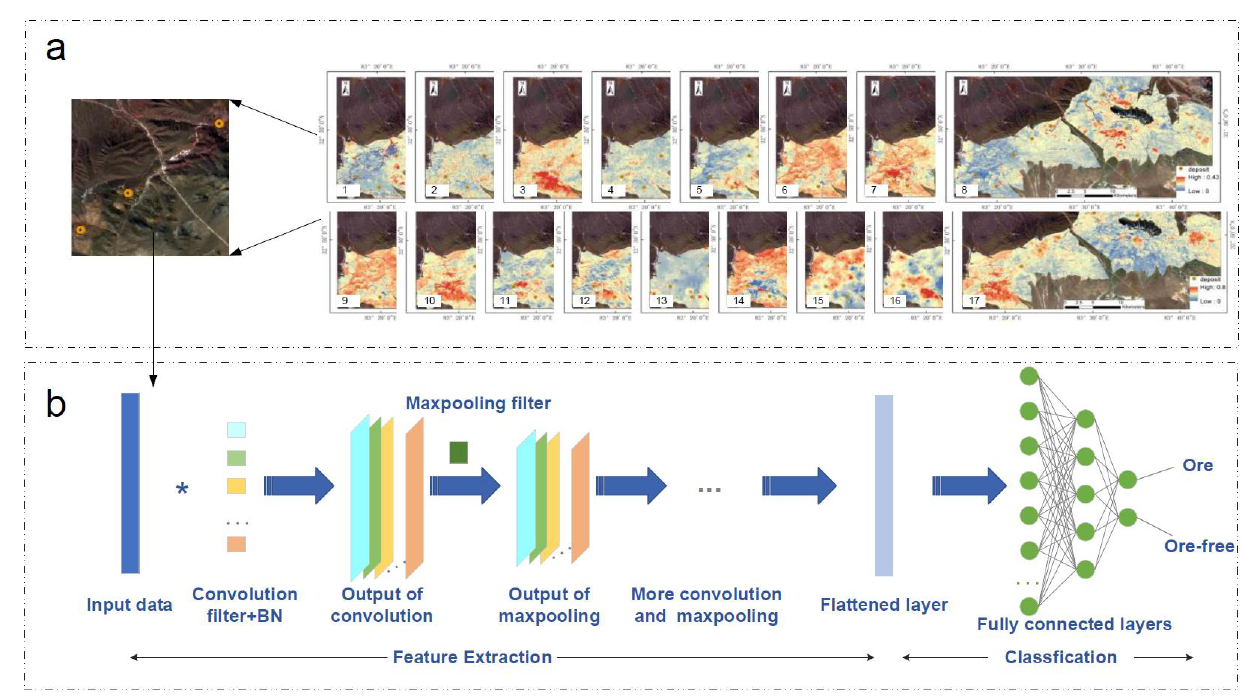
Figure 4. Two components of the designed 1-D CNN model construction: ( a ) The architecture of the dataset; and ( b ) The structure of the specific network, * represents the convolutional operation performed on the input data with the convolution filter.